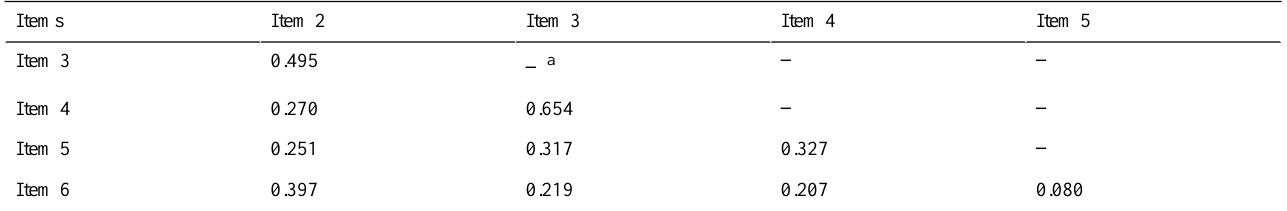
Table 5. Inter-item correlation matrix.